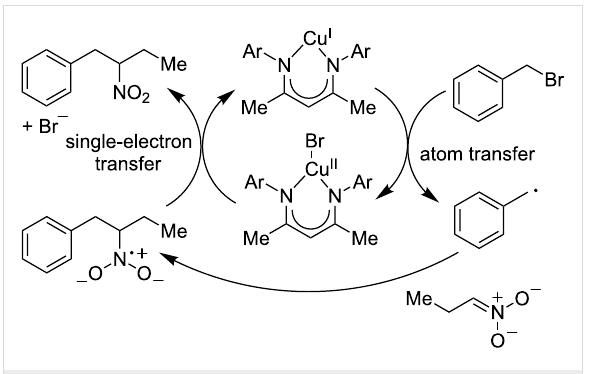
Scheme 5: Possible mechanism of the thermal redox